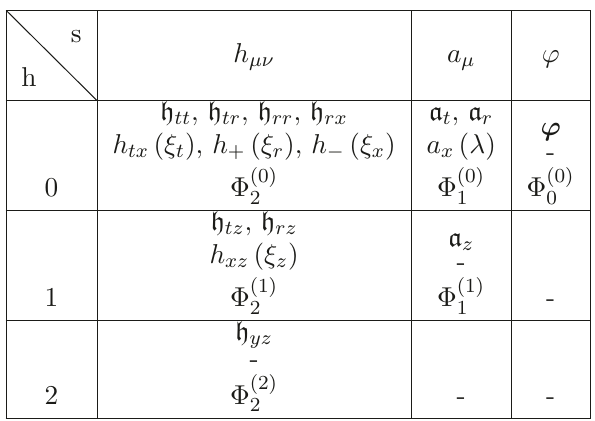
Table 2 . Decoupling of sectors into gauge-independent components. For each sector and each field we list first the gauge-invariant components, then in the line below the gauge-dependent ones and behind them in brackets the gauge parameter that can be used to set it to zero. The bottom line is the master scalar of that field in that